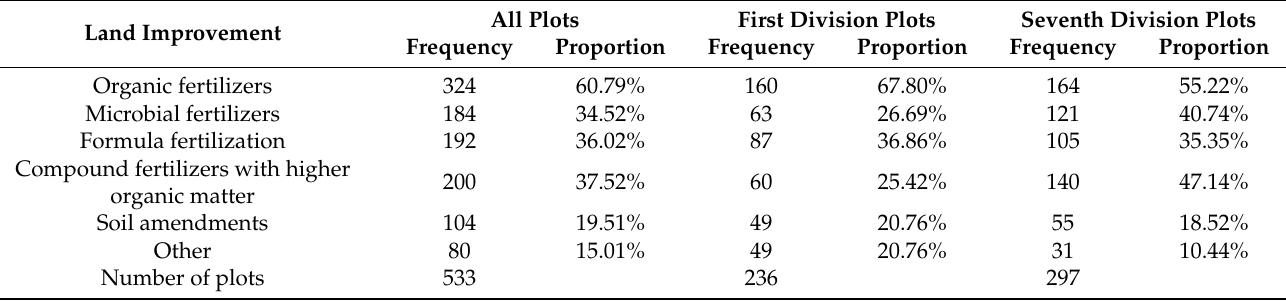
Table 3. Description of farmers’ land improvement